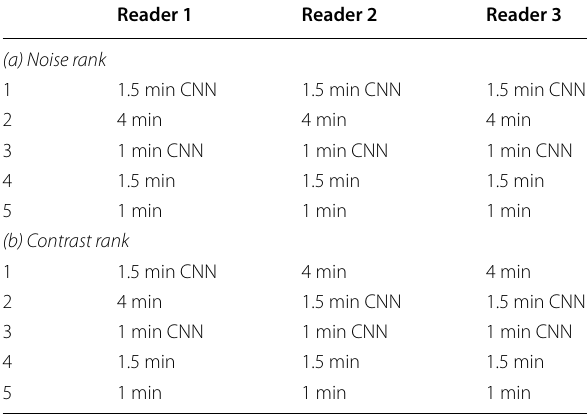
Table 5 Image sets ranked by mean noise and contrast score for all readers, 1 best =